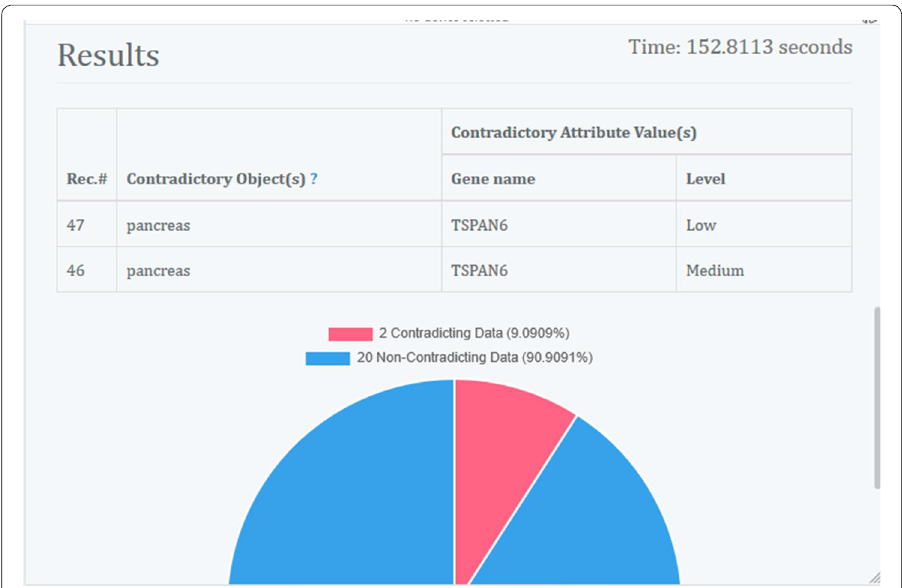
Fig. 2 Result of the analysis of the normal tissue dataset by ConTra’s multiple attribute values